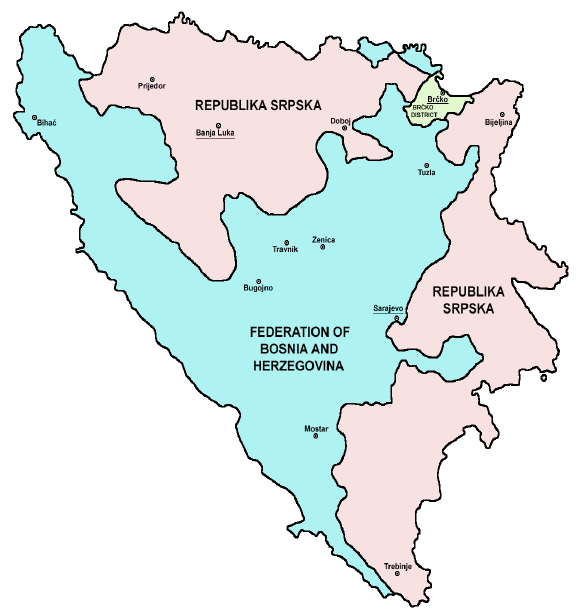
Fig. 2. Map of the inter-entity